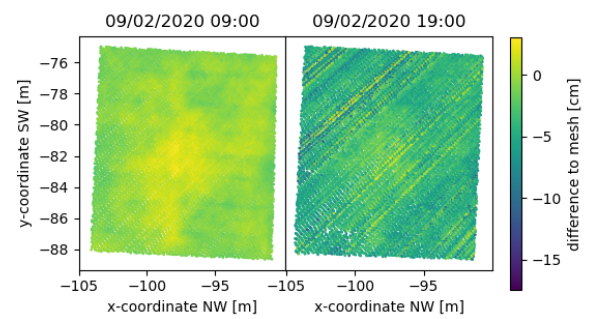
Figure 1. Residual plots of the helipad on 09/02/2020, at 09:00 (left) and at 19:00 (right). Colours represent distance to a reference mesh in cm. On the right much larger differences in a striped pattern are